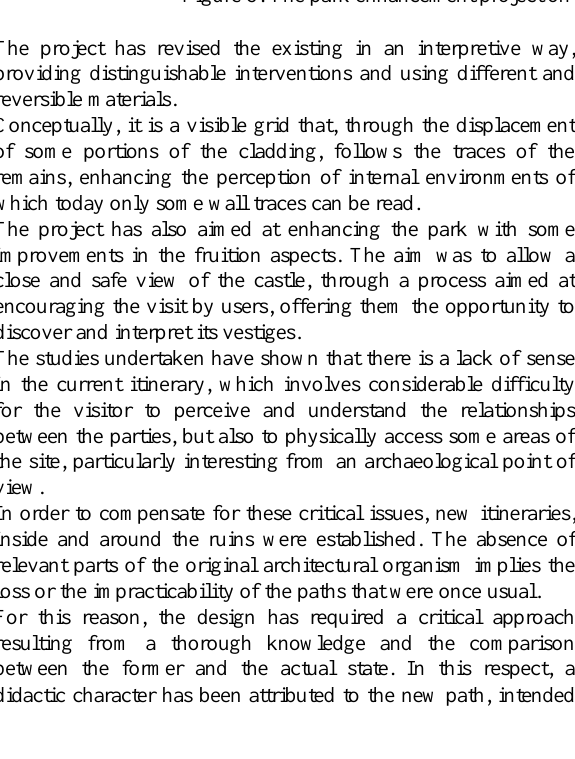
Figure 5. The park enhancement project on the 3D model obtained by the survey